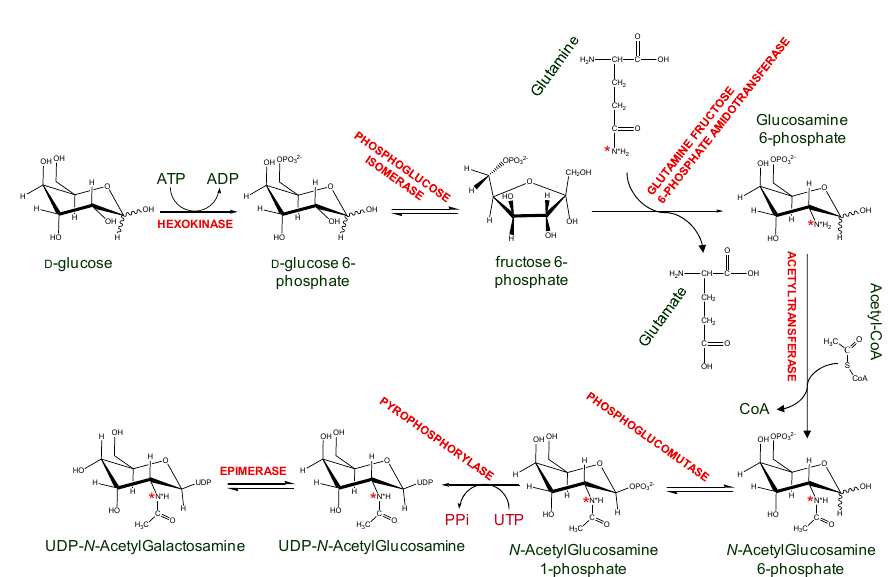
Figure 9. Schematic representation of the cytosolic biosynthesis of 15 N-labeled UDP- N - acetylgalactosamine and UDP- N -acetylglucosamine, using side chain 15 N-labeled glutamine as 15 N donor. These nucleotide- N -acetyl-hexosamines will be further used inside the Golgi apparatus to synthesize GAG backbones in proteoglycans. The names of the enzymes are fully written in red while the substrates and products are mostly written in black. The 15 N-labeling are indicated with the red asterisks throughout the reaction steps. Adapted with permission from Pomin et al. Analytical Chemistry 2010, 82, 4078–4088. Copyright 2018 American Chemical Society [42].